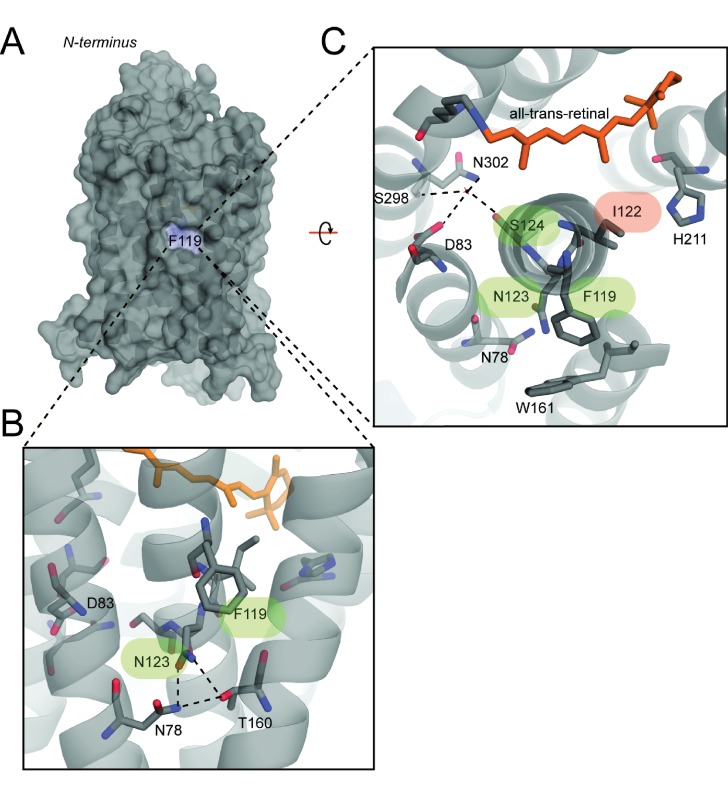
Compensatory effects at coevolving sites are mediated by a diversity of possible structural mechanisms.(A) Overview of a homology modeled mutant rhodopsin MII structure containing the FINS motif (Materials and methods) (Choe et al., 2011. F119 is membrane-facing (blue). (B) Zoom-in of F119 and buried-site N123, which may form novel hydrogen bonds with nearby conserved residues N78 and T160. These interactions may alter the conformation of residues near S124, as shown in (C) where D83, S298 and N302 participate in a hydrogen bond network stabilizing the active-conformation (Choe et al., 2011). Cascading structural alterations from F119, to N123 to S124 (green) may therefore increase active-conformation stability by integrating into existing stabilizing motifs, therefore compensating for the loss of the E122-H211 hydrogen bond (red).